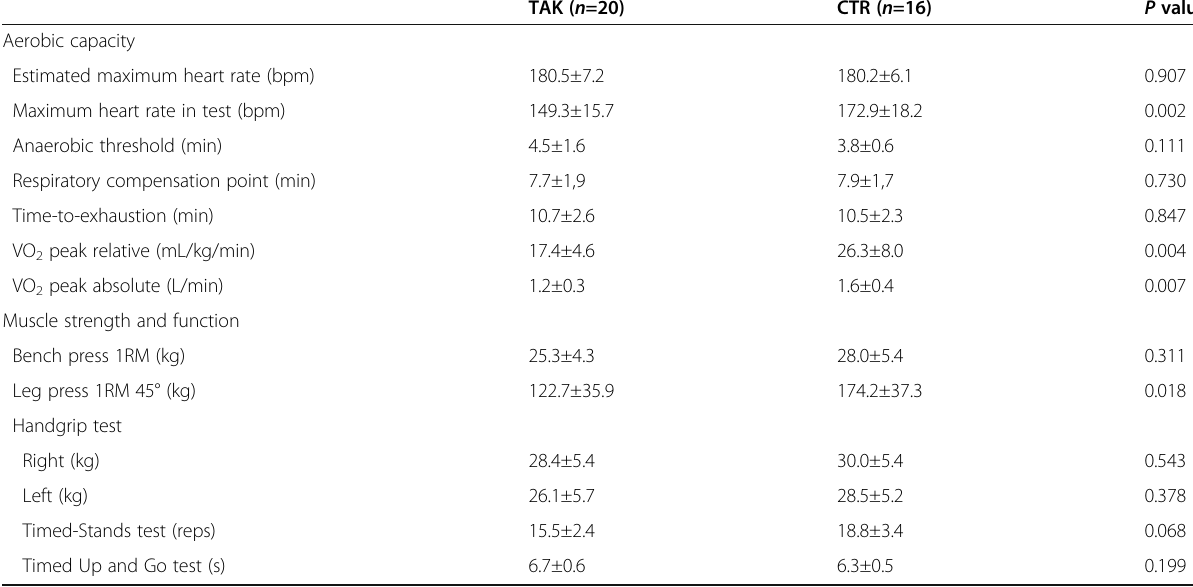
Table 3 Parameters of aerobic capacity, strength and functional capacity of patients with Takayasu arteritis and the control group TAK ( n =20) CTR ( n